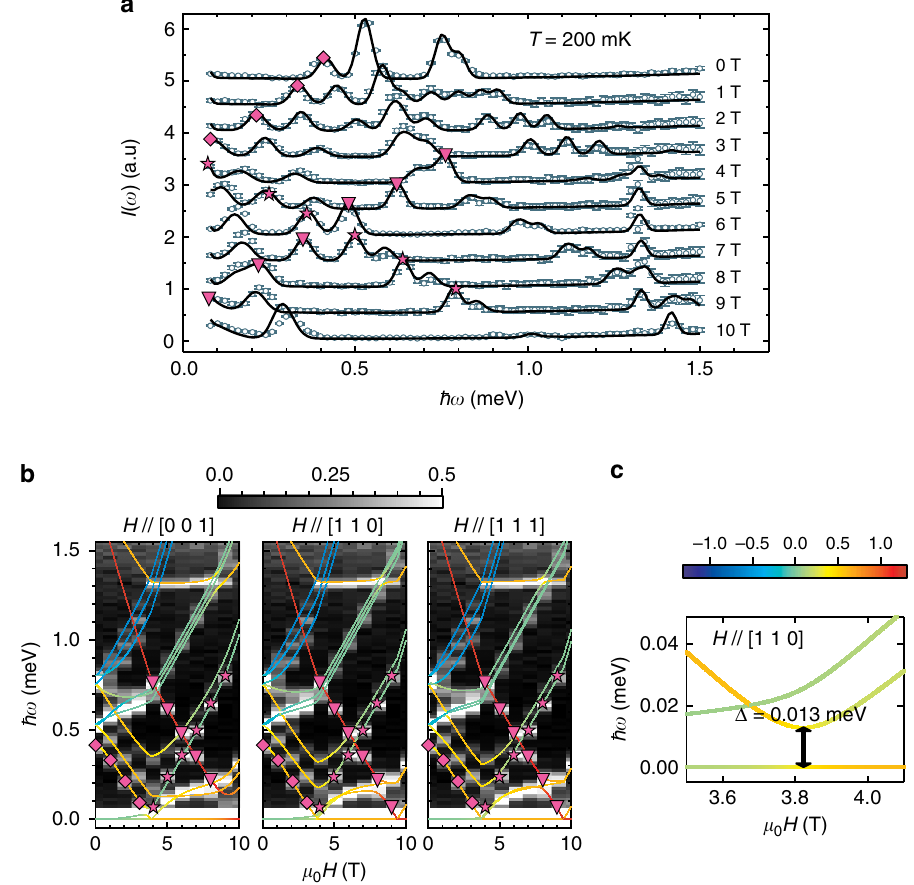
Figure 3 | Field-dependent INS spectra and evolution of excitation energies. ( a ) Constant- Q cuts I ( o )’s obtained by integrating measured I ( Q, o )’s over a range of 0.8Å (cid:2) 1 o Q o 1.8Å (cid:2) 1 at T ¼ 200mK in external magnetic fields ranging from H ¼ 0 to H ¼ 10T. Solid lines are obtained by fitting the experimental I ( o )’s with parameters of J , d and g -factors in H eff . ( b ) Calculated excitation energy diagrams as a function of the H -field along the three principal axes [0 0 1], [1 1 0] and [1 1 1] are overlapped on the contour map of I ( o )’s. Excitation peak positions of I ( o )’s agree well with calculations. Peak intensites are presented by the grey scale bar. Selected three excitations, related to the level crossings at H C1 and H C2 are, respectively, marked with stars, diamonds and triangles in a and b . ( c ) Avoided level crossing along H //[1 1 0] near H ¼ H C1 in a low-energy region. The colour scale bar represents the magnetization value o g S z 4 per Yb for the line colours in b and c . On the other hand, the avoided level crossing feature appears along H //[0 0 1] near H ¼ H C2 . Intensity error bars are square roots of